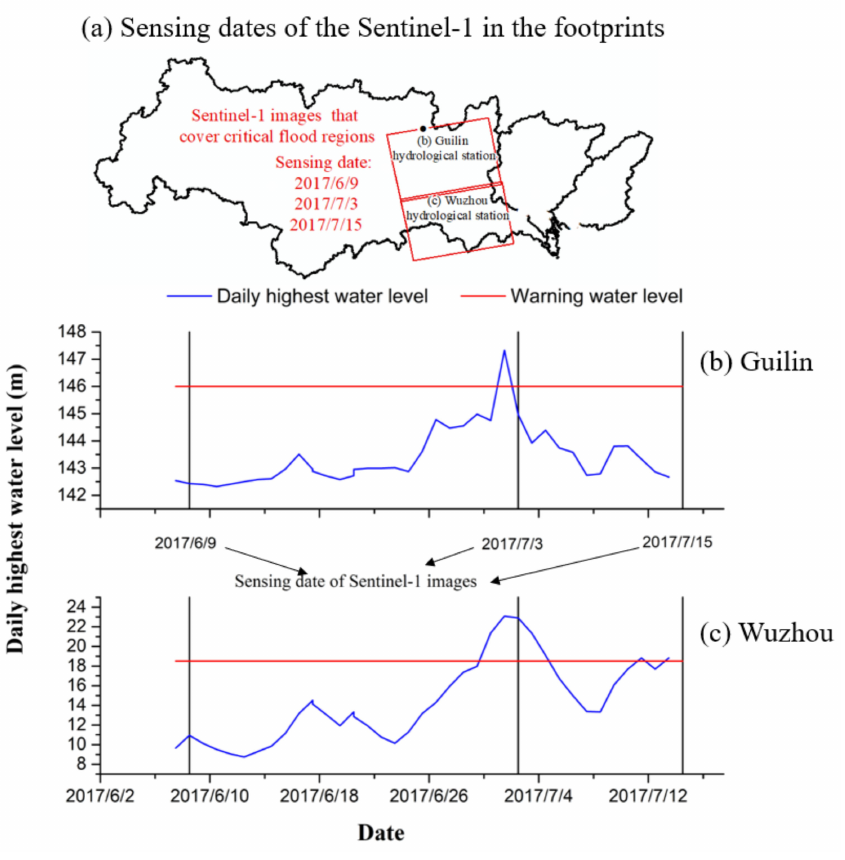
Figure 9. Comparison of the return period of Sentinel-1 images in major flooding regions correspond- ing to the date of flood peaks. ( a ) Sensing dates of the Sentinel-1 in the footprints; ( b ) daily highest wa- ter level at Guilin Hydrological Station; ( c ) daily highest water level at Wuzhou Hydrological